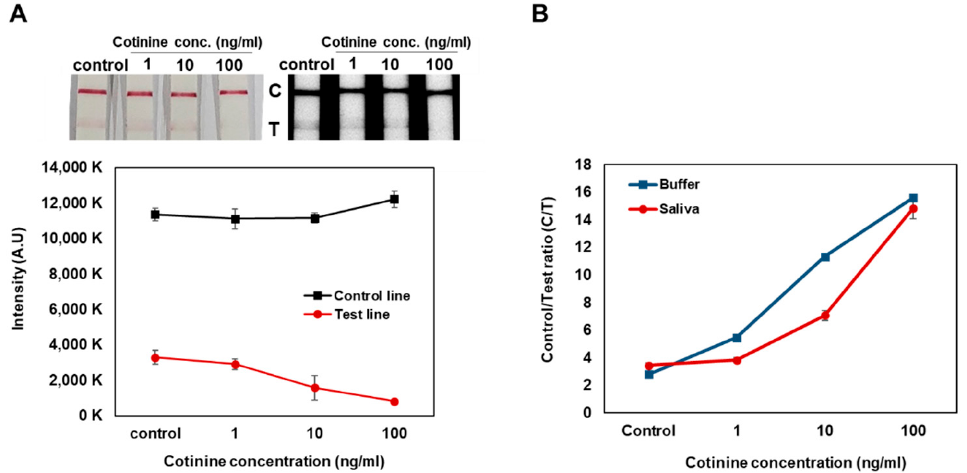
Figure 3. Cotinine concentration test spiked in saliva by the gap-LFIA with 25 ng/mL anti-cotinine antibody on conjugate pads. ( A ) Comparison for intensities of control line and test line. ( B ) Conversion to Control to Test ratio. All data shown are presented as the mean ± SD ( n = 3).